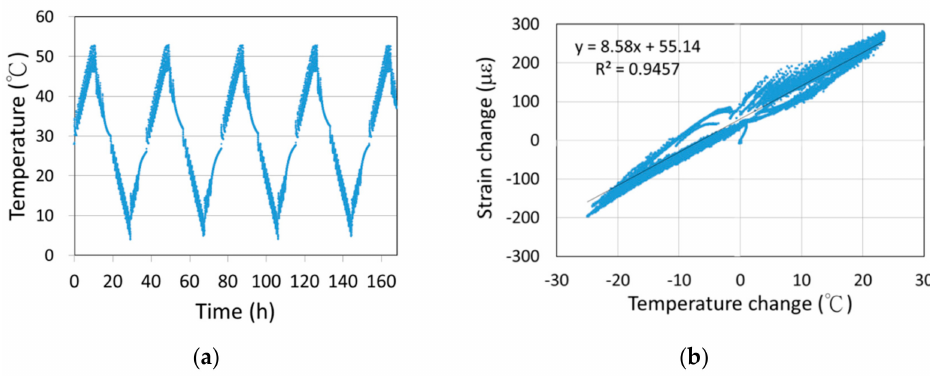
Figure 5. The temperature-resistance e ff ect of the strain gauge (PFL-20 mm) attached to the Zerodur glass ceramic plate: ( a ) temperature changes; ( b ) strain change and temperature relationship.